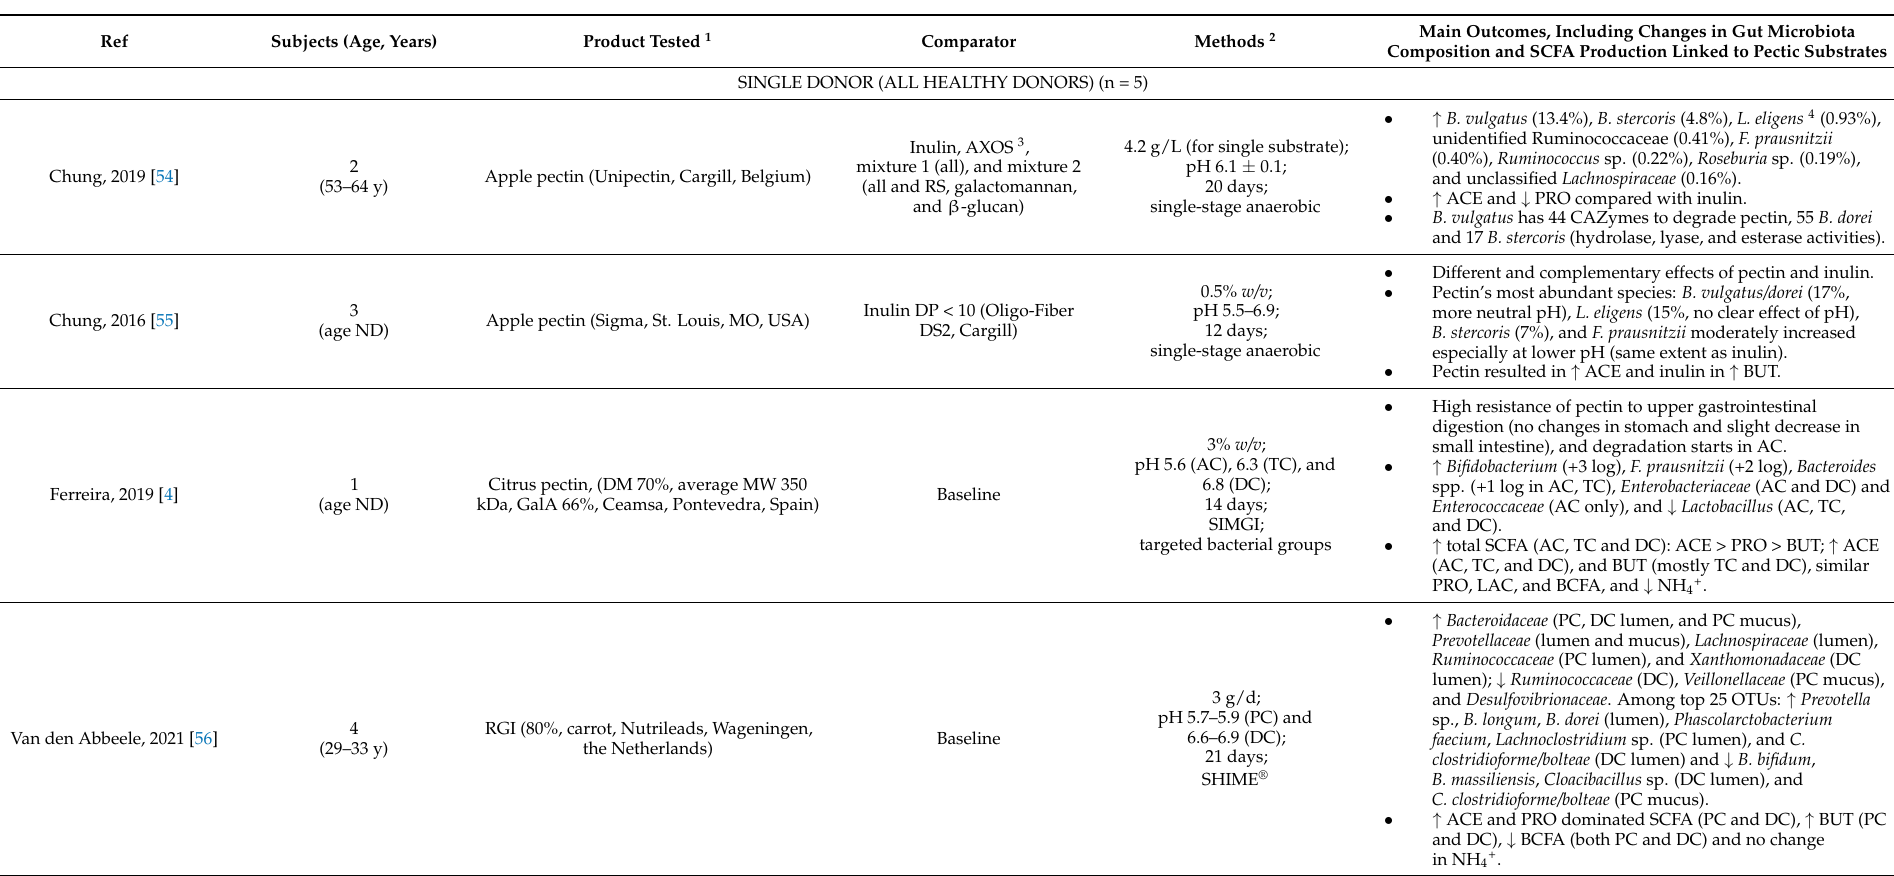
Table 3. In vitro continuous fermenter studies with human gut microbiota; n = 11: 5 single donor; 6 with pooled samples (healthy vs. specific